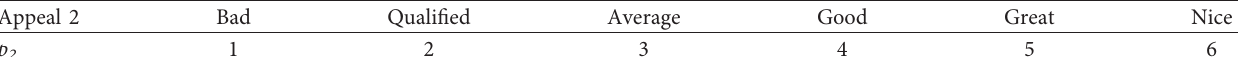
Table 2: Value of response to appeal 2 ( p